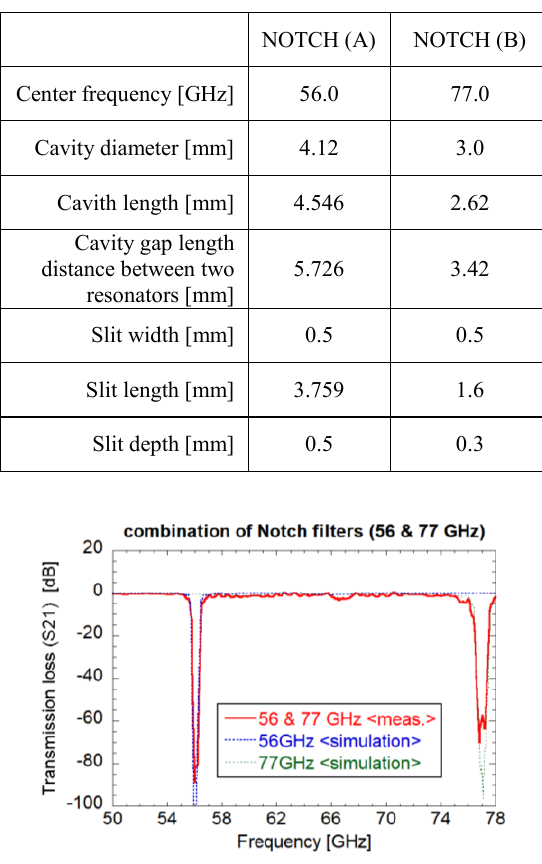
Table 1. Design parameters for V-band notch filters for 56GHz and 77 GHz.